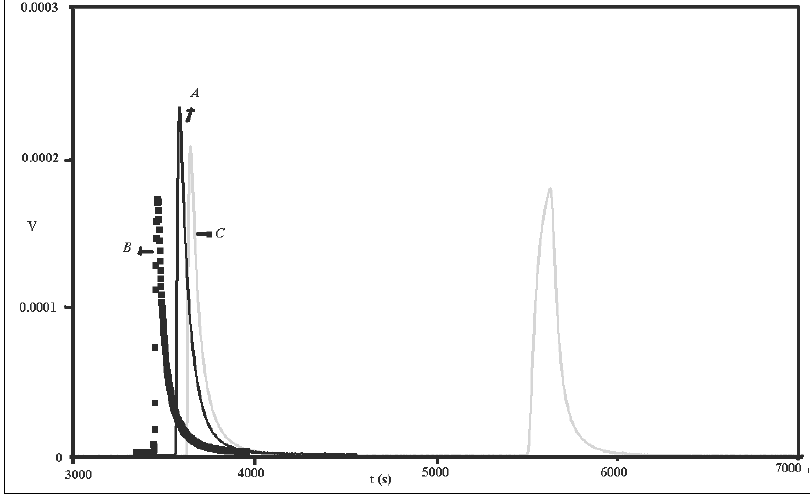
Figure 3. Calorimetry thermograms obtained for the immersion in benzene of the series) MD32 b) MD20 c) MD48 immersion peaks d) Calibration